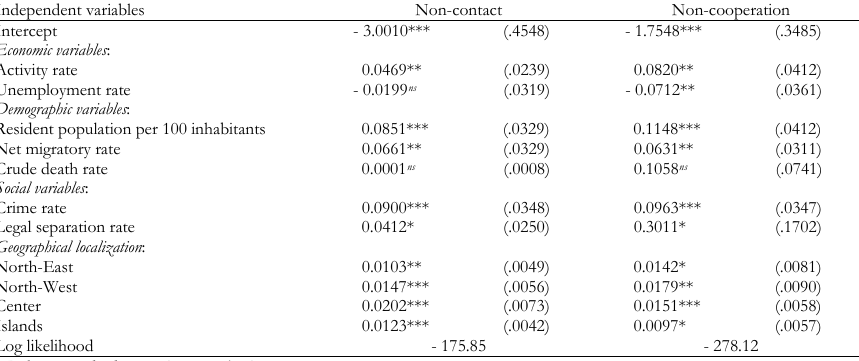
Multinomial logistic model: non-contact and non-cooperation vs participation – wave 2005 Independent